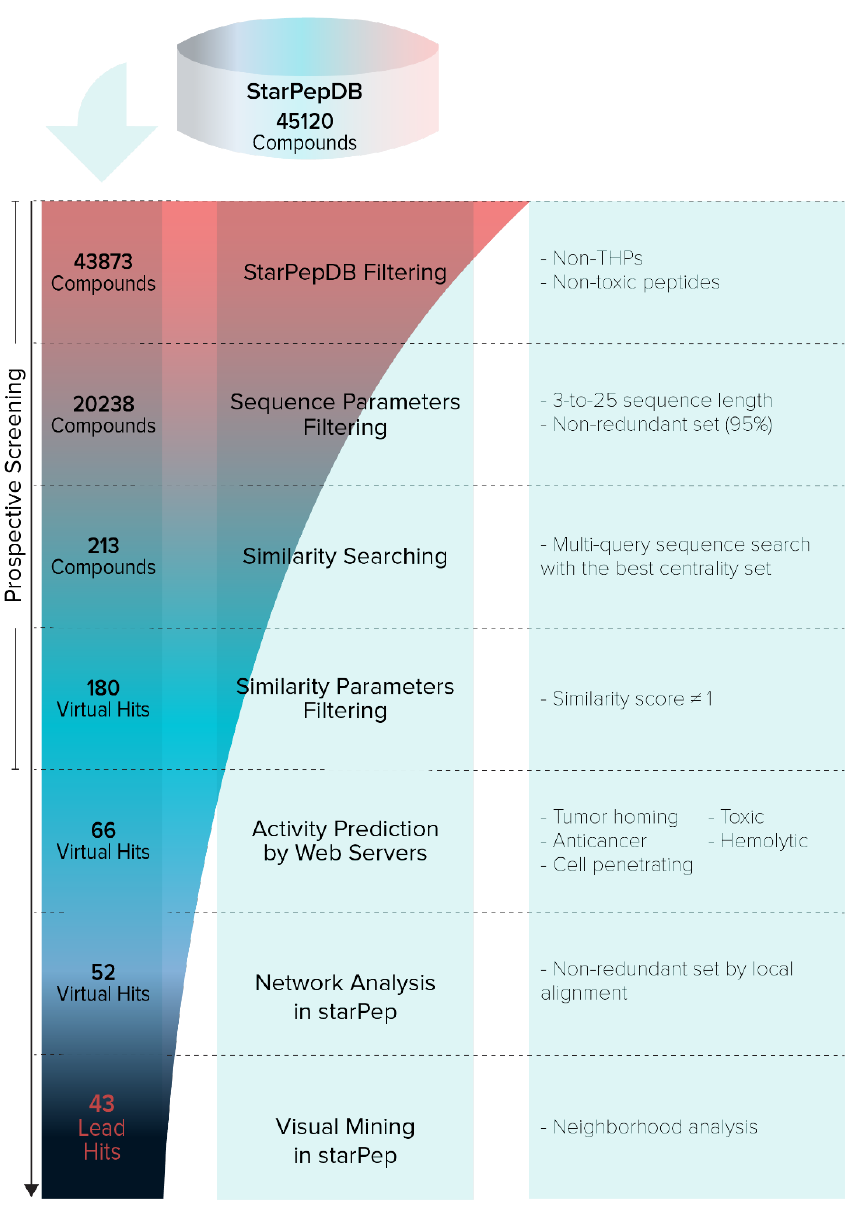
Figure 9. Hierarchical virtual screening for repurposing of peptides from starPepDB.